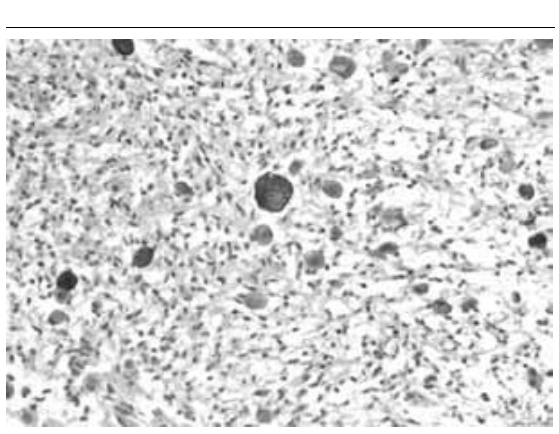
figurE 4 – Ganglion cell immunostained with NF in ganglioglioma. Note granular cytoplasm/microvacuolated (lens 10×) NF: neurofilament.